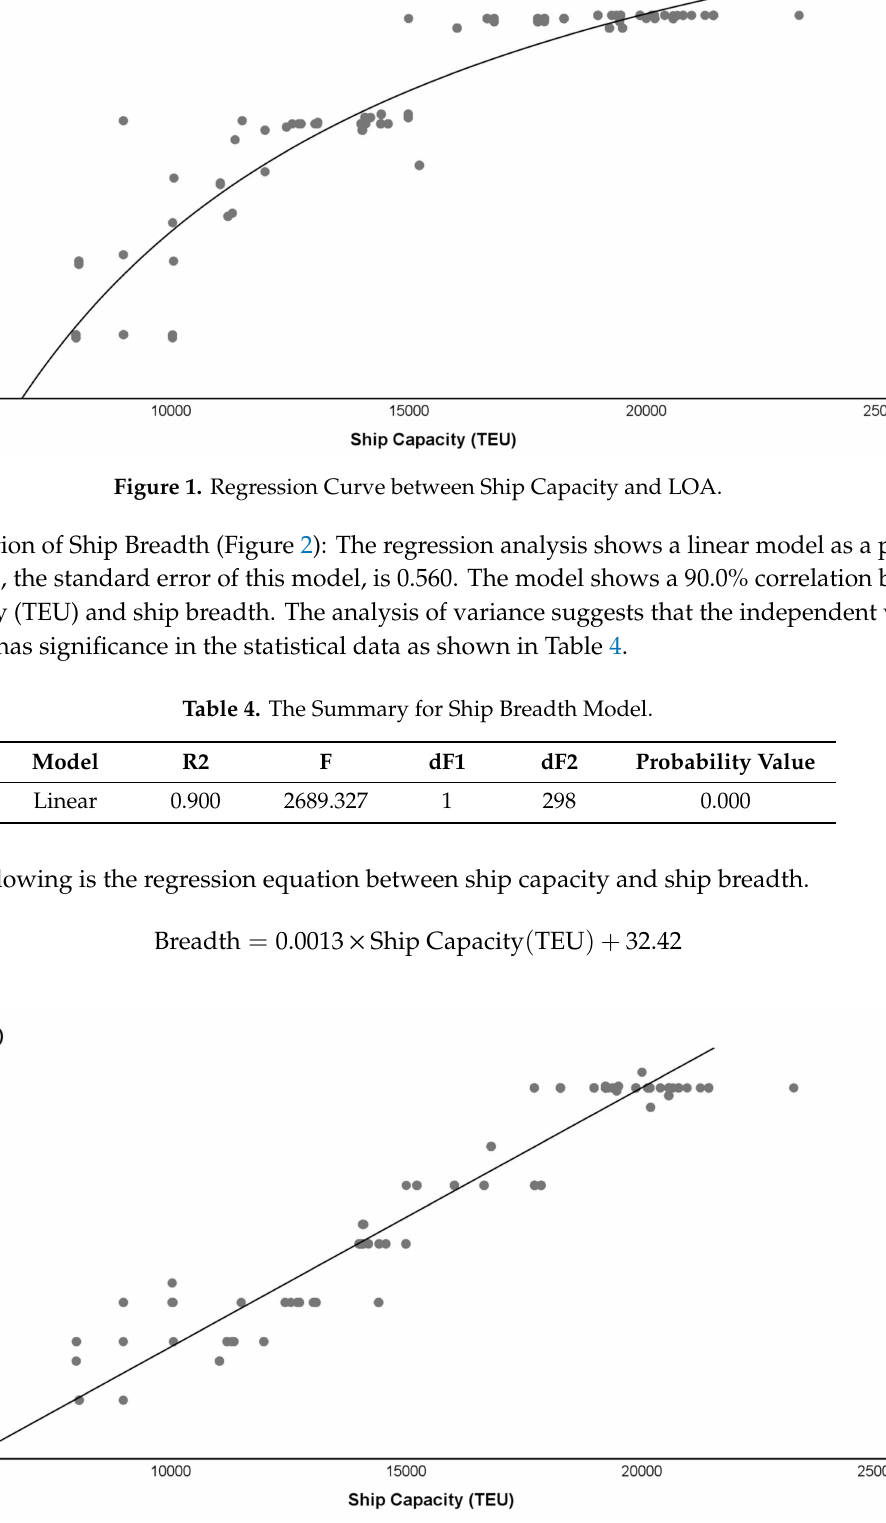
Figure 2. Regression Curve between Ship Capacity and